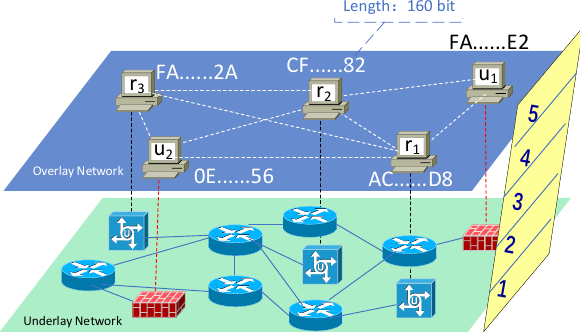
Figure 9. The overlay network is an application layer network with a series of reachable nodes r 1 , r 2 , r 3 and unreachable nodes u 1 , u 2 in the plane, and they have the same format of 160 bit logical addresses; The lower underlay network represents layers 1 to 4 of the TCP/IP stack, with nodes accessing the network in different ways and at different